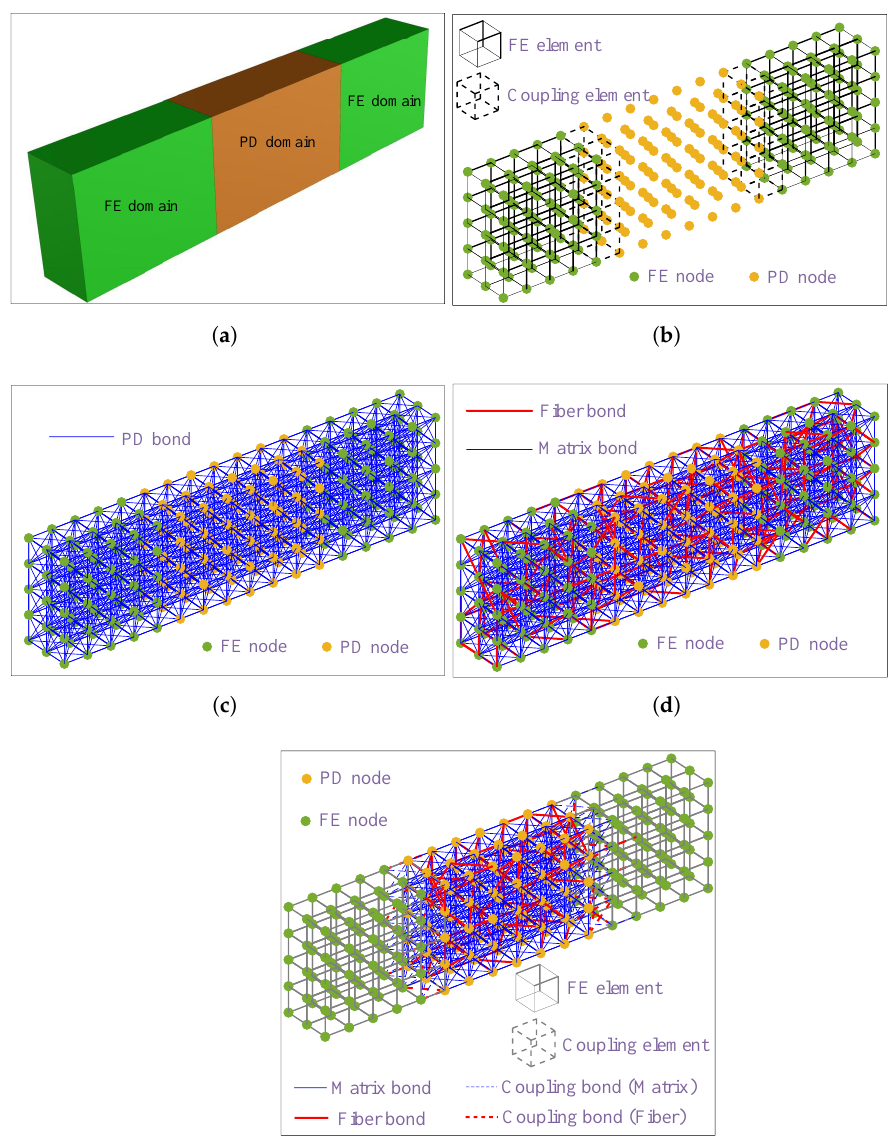
Figure 5. The diagrammatic sketch for the illustration of the hybrid FE/PD modeling procedure of the UHPC-PVA structures. Note that the size of the grid does not represent the real one used in the simulations. ( a ) Modelling schematic of a beam specimen; ( b ) Step 1: the hybrid FE/PD discretization; ( c ) Step 2: PD bond connections for all nodes; ( d ) Step 3: random selection of fiber bonds; ( e ) Step 4: the complete hybrid FE/PD